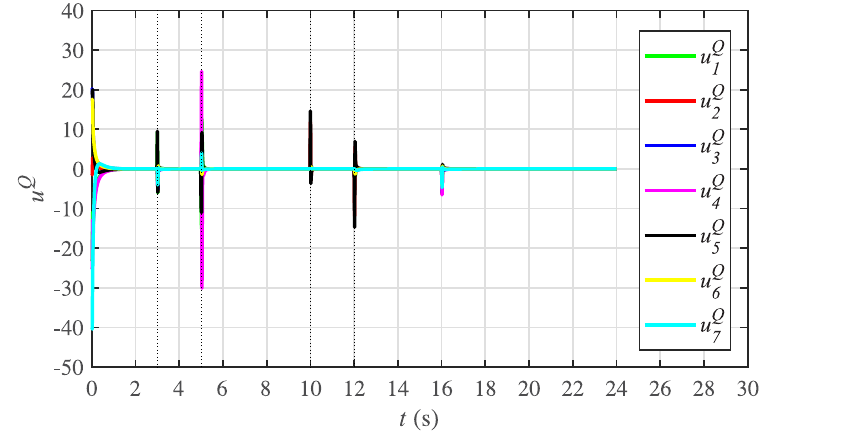
Fig 27. Reactive power control efforts under case 2.